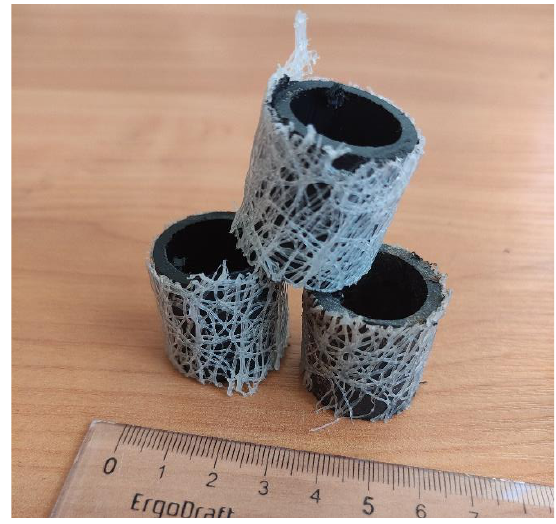
Figure 8. TF Filter elements.